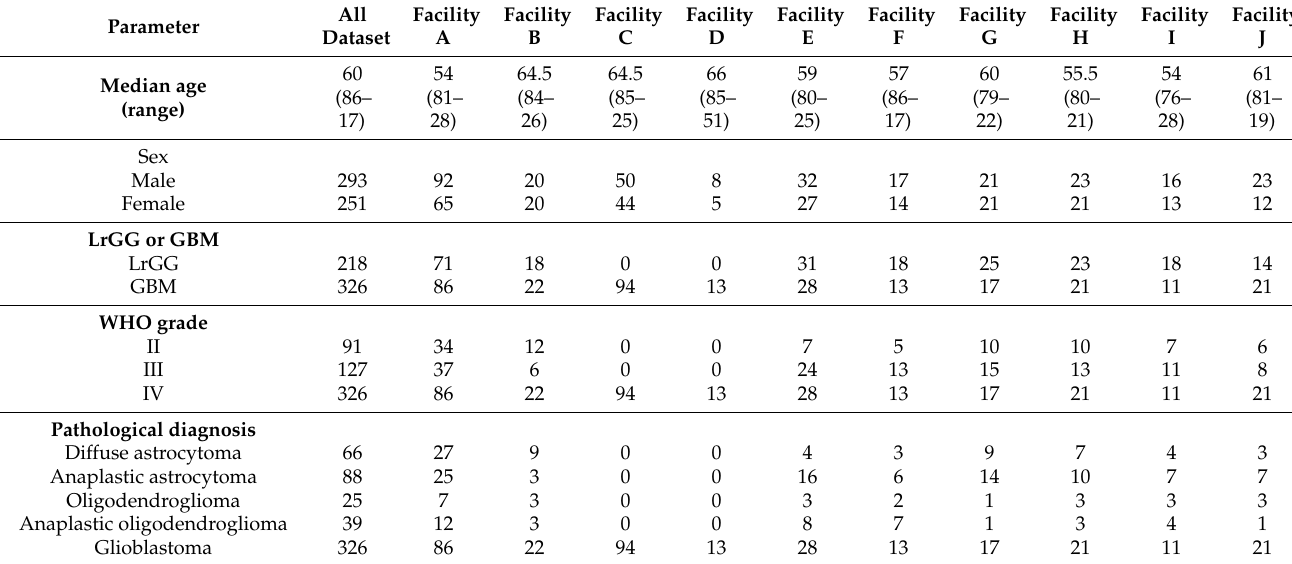
Table 1. Clinical characteristics of the cases in this